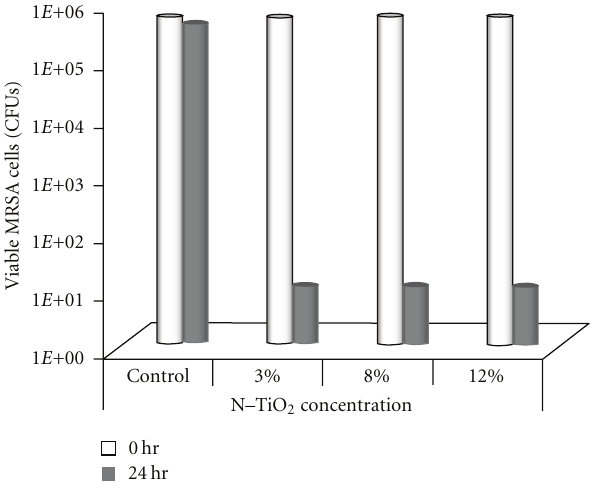
Figure 6: Enhancement of bactericidal activity by addition of N- doped TiO 2 to PTFE material, comparing with the N-doped TiO 2 alone coating. The 8% N-doped TiO 2 -added PTFE film (8%NT- PTFE) and 8% N-doped TiO 2 alone coating (8% NT) were used in comparison tests.